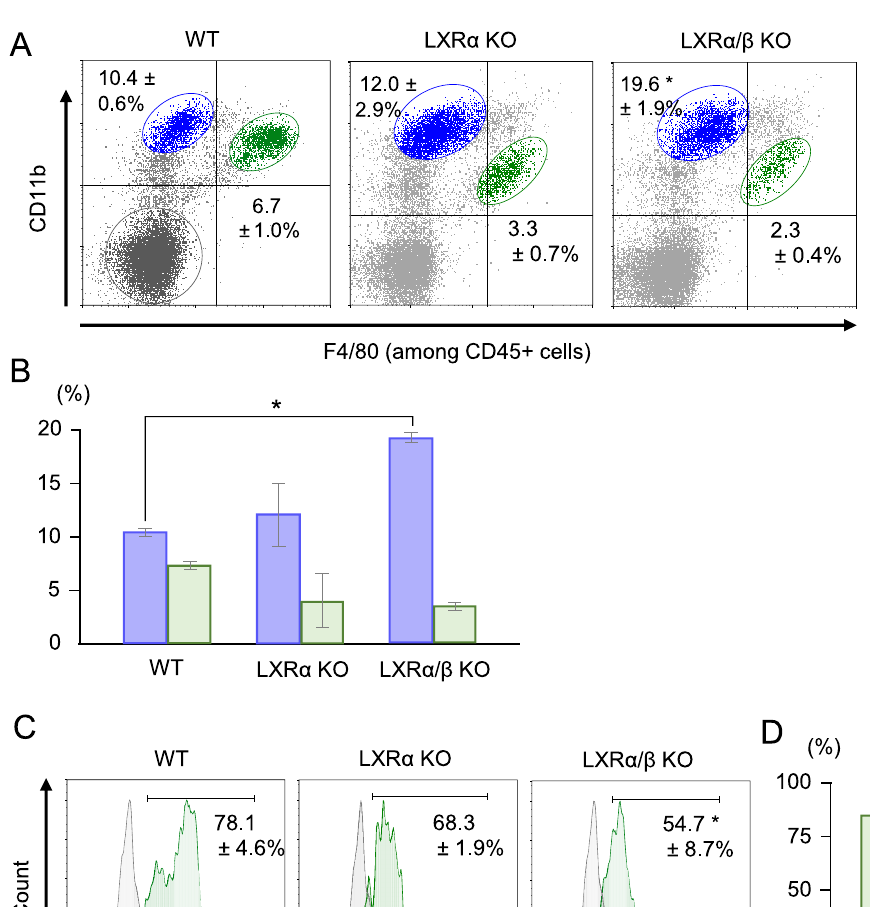
PLOS ONE | https://doi.org/10.1371/journal.pone.0254886 July 23,